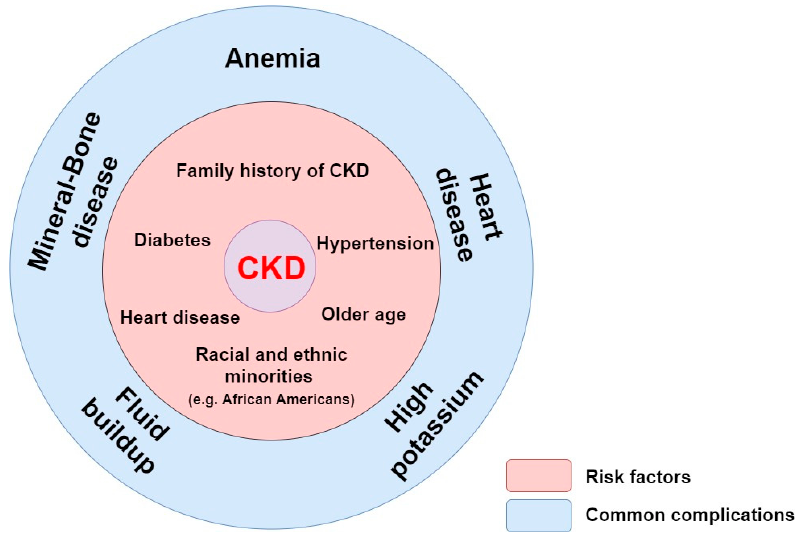
Figure 1. Risk factors and common complications for CKD. In pink are represented the risks factors: family history of CKD, hypertension, diabetes, heart disease, older age, and racial and ethnic minorities. In blue are represented the common complications: anemia, heart disease, mineral and bone disease, fluid buildup, and high potassium.